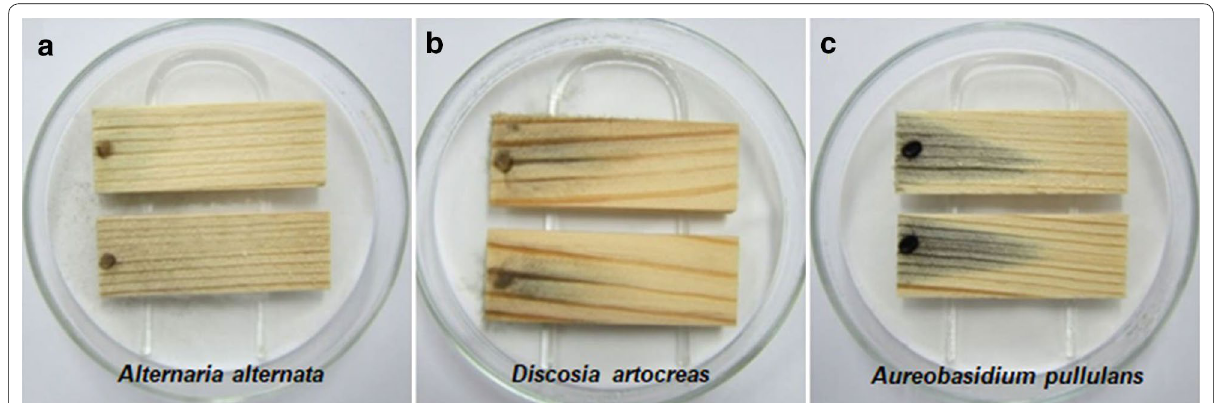
Fig. 2 Discoloration intensity of wood surface by mold and stain fungi; the discoloration was rated as: a 1 discoloration; and c 3 heavy =